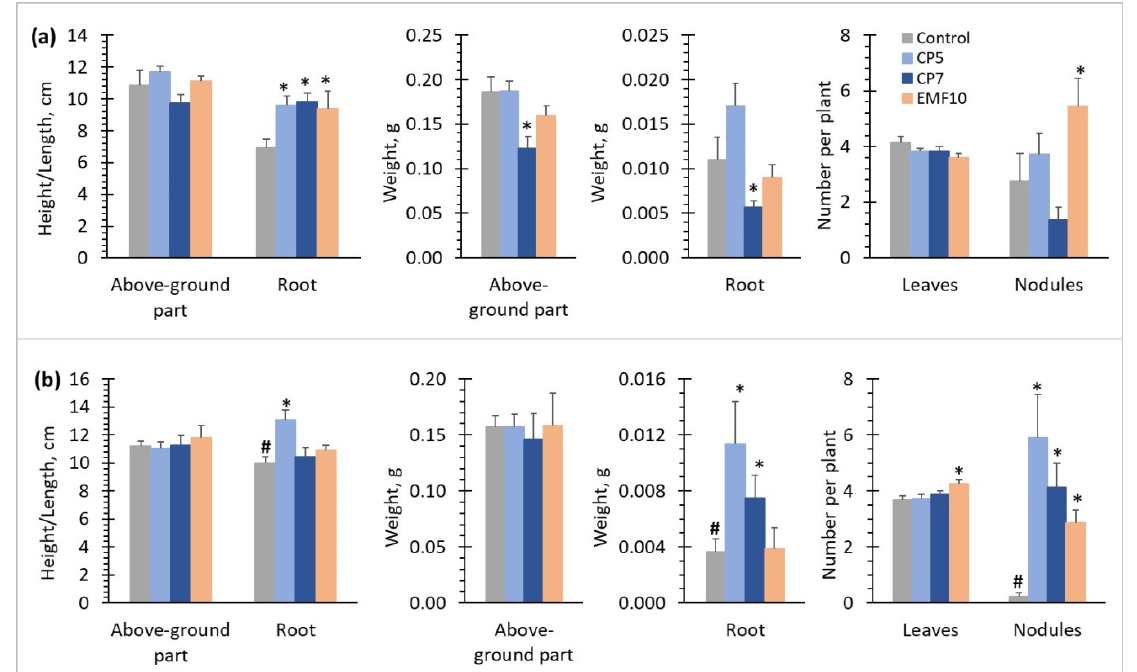
Figure 4. Morphometric parameters of red clover seedlings grown in rhizoboxes 5 weeks after sowing. Seedlings were grown from yellow ( a ) and dark purple ( b ) seeds. Mean values ± standard error are presented. The number of seedlings in the experimental group was n = 19–23. * Significantly different from the control group ( p ≤ 0.05); # significantly different from seedlings growing from control yellow seeds ( p ≤ 0.05).